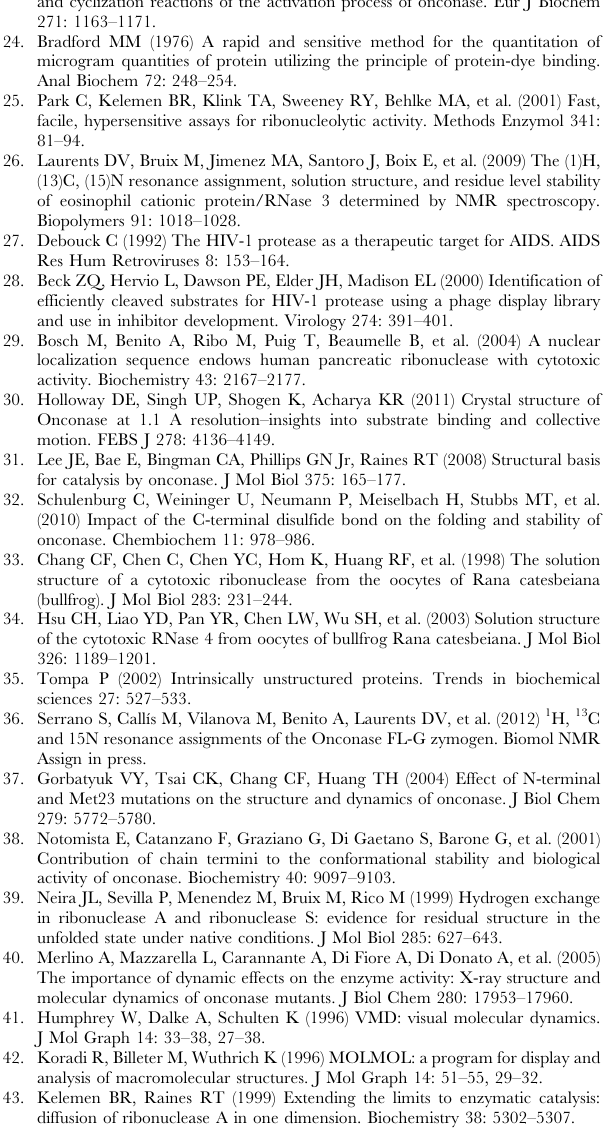
Table S1 Theoretical and experimental molecular masses of the proteins used in this